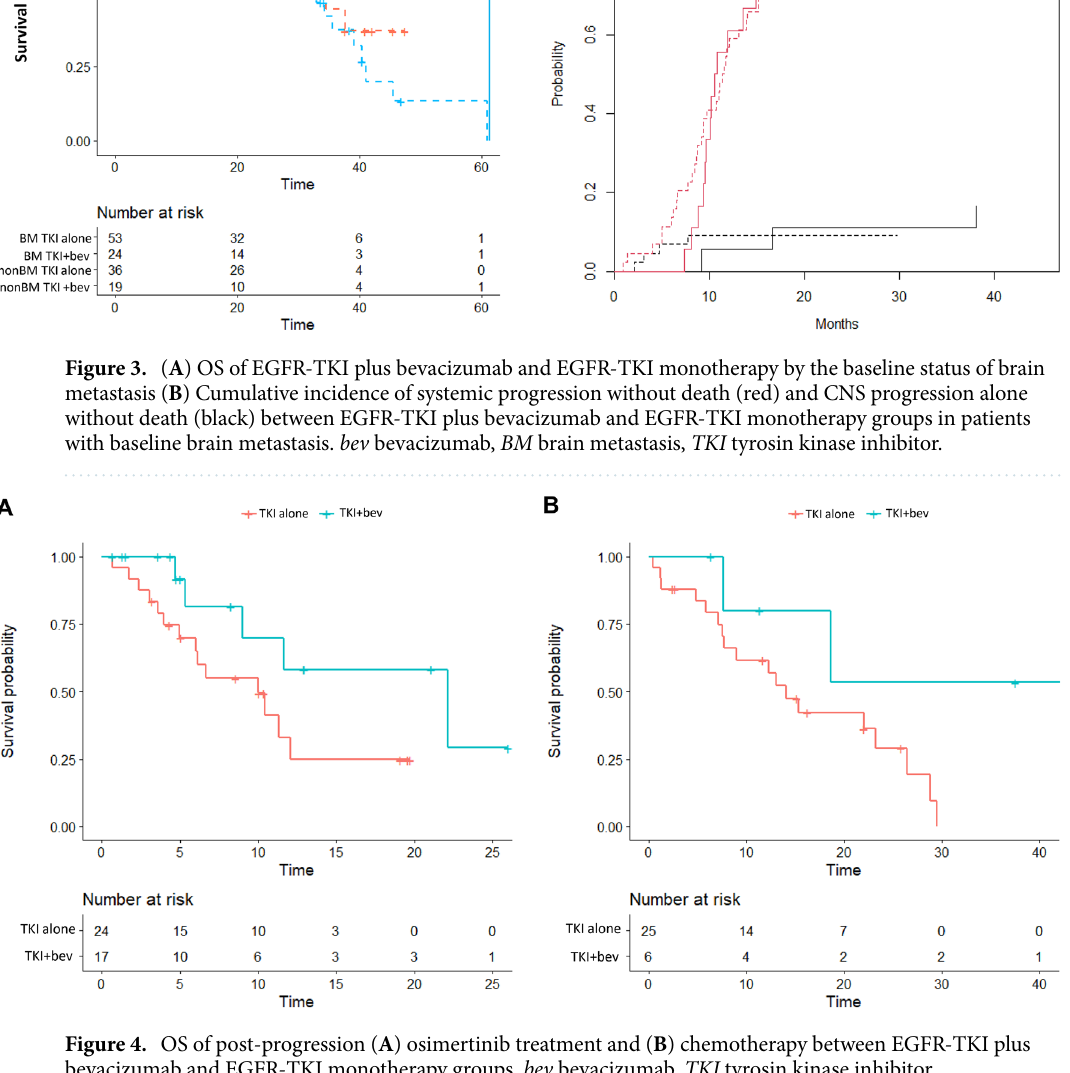
Figure 4. OS of post-progression ( A ) osimertinib treatment and ( B ) chemotherapy between EGFR-TKI plus bevacizumab and EGFR-TKI monotherapy groups. bev bevacizumab, TKI tyrosin kinase